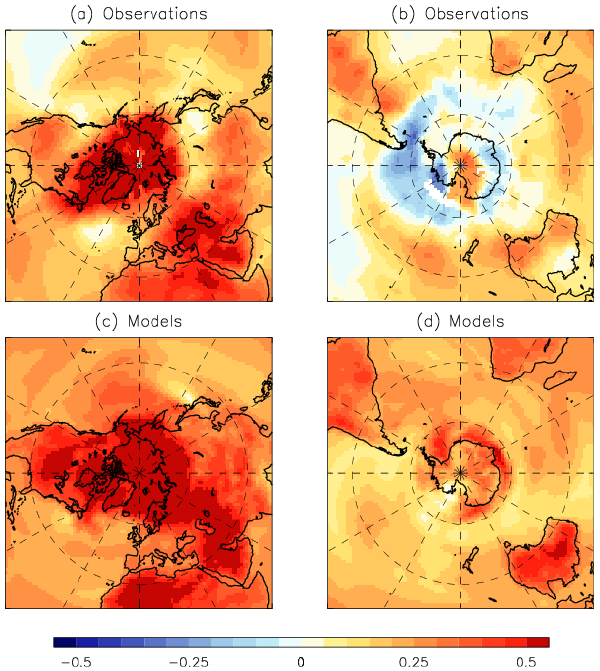
Figure 2. Recent Arctic and Antarctic temperature trends ( ◦ Cdecade − 1 ) in (a, b) observations and (c, d) model simulations. Linear trends are shown for the 30-year period (1988 to 2017). Ob- servations are taken as the average of HadCRUT4 (Morice et al., 2012), NASA-GISS (Hansen et al., 2010) and NCDC (Karl et al., 2015). Model trends are computed as the average from 25 CMIP5 model simulations driven by historical and RCP4.5 radiative forc-